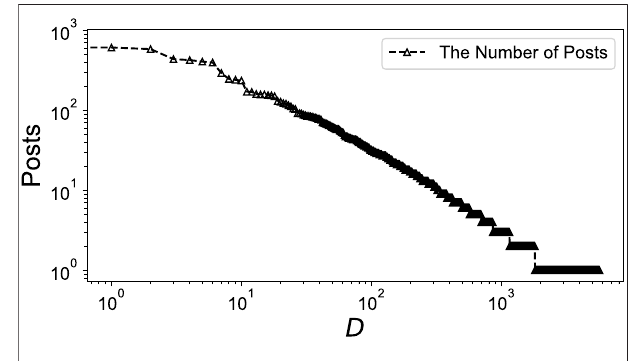
FIGURE 2 | Number of posts in each summarized post D